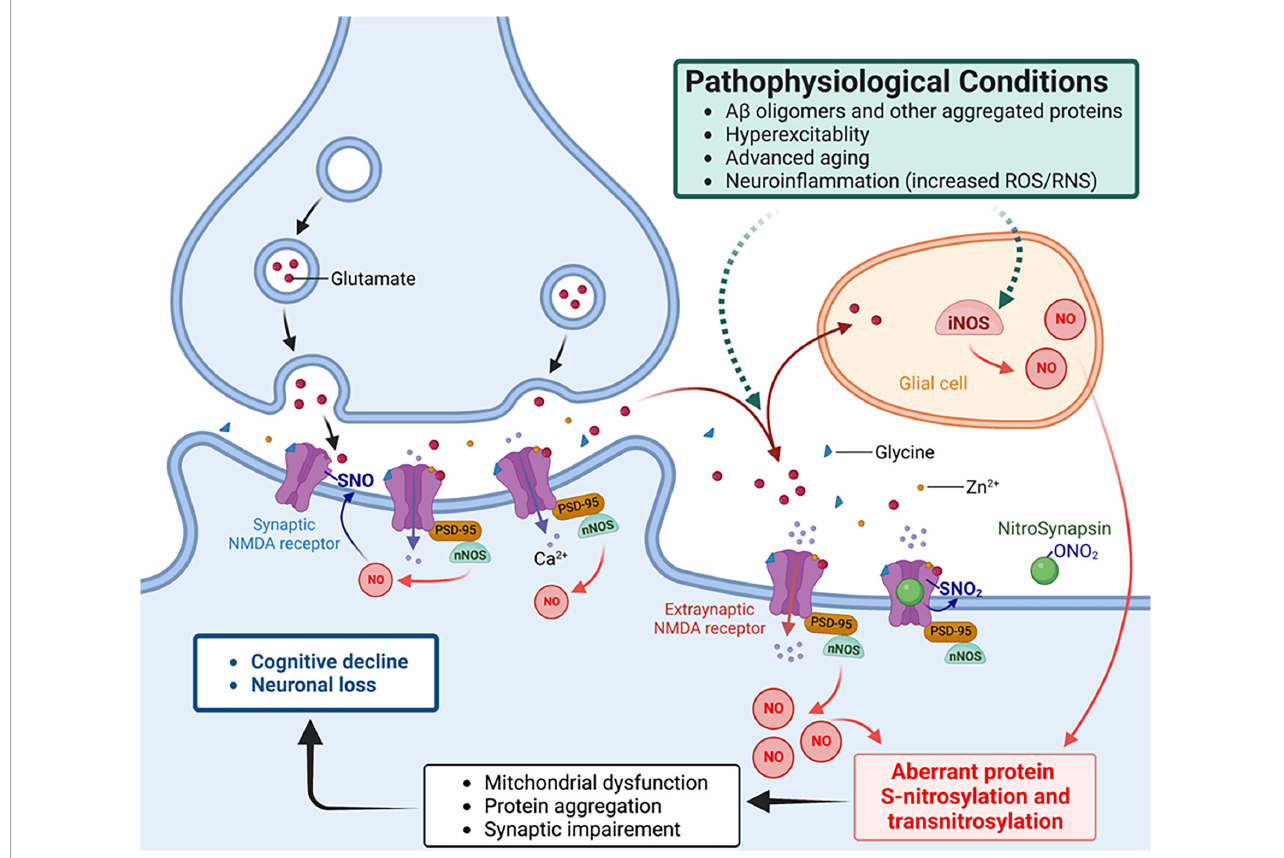
FIGURE2 NitroSynapsin ameliorates aberrant S-nitrosylation that contributes to the pathophysiology of hyperexcitability and synaptic dysfunction in Alzheimer’s disease (AD). Oligomerized amyloid- β peptide (A β ), neuronal hyperexcitability, aggregated proteins, and neuroinflammation can each trigger excessive NO production via inducible or neuronal NO synthase (glial iNOS or neuronal nNOS – the latter is physically tethered to the NMDA receptor), resulting in aberrant protein S-nitrosylation. The ensuing abnormal signaling mediated by protein S-nitrosylation and transnitrosylation results in mitochondrial fragmentation, bioenergetic compromise, and consequent synaptic impairment (Nakamura et al., 2021a,b). NitroSynapsin is a unique drug candidate that manifests dual actions to inhibit excessive (mainly extrasynaptic) NMDA receptor activity, thereby limiting subsequent NO production and its consequent downstream damage to synapses. Mechanistically, NitroSynapsin blocks the receptor’s ion channel when it is excessively open through its aminoadamantane moeity, and then delivers a nitro (–NO 2 ) group specifically to the NMDA receptor at sites of S-nitrosylation to further decrease excessive receptor activity. SNO, S-nitrosylation or S-nitrosothiol; PSD-95, postsynaptic density protein